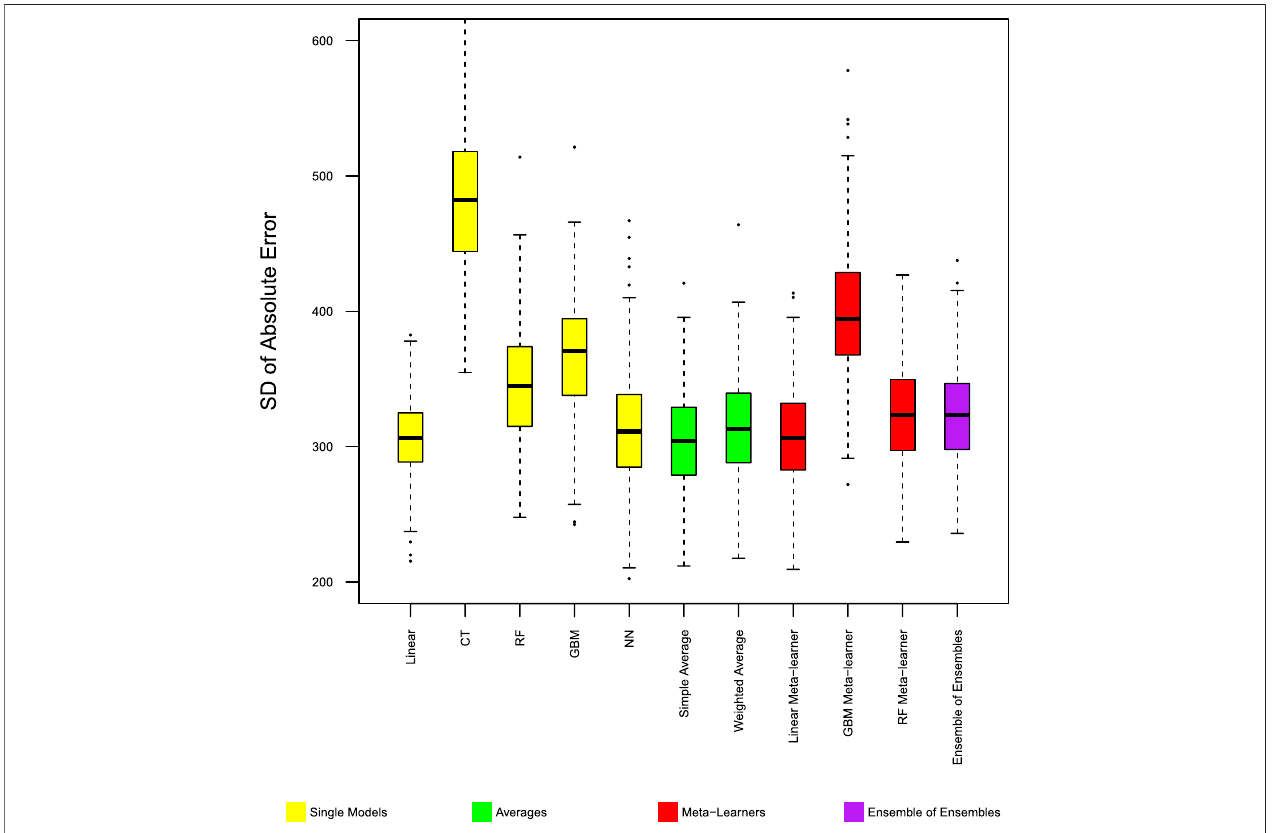
FIGURE 6 | Model performance in predicting trip production — NYC SD absolute error. Distribution of SD of absolute error from 400 experiments. Base models exclude the classi fi cation tree.